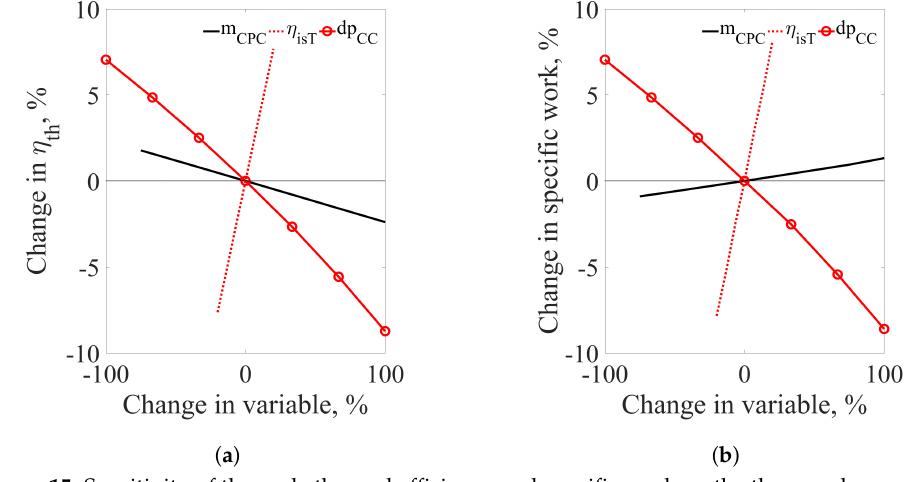
Figure 15. Sensitivity of the cycle thermal efficiency and specific work on the three cycle parameters presented in Table 4. Pressure ratio: 10, TIT: 1300 ◦ C. ( a ) Sensitivity of the cycle thermal efficiency; ( b ) Sensitivity of the cycle specific work.